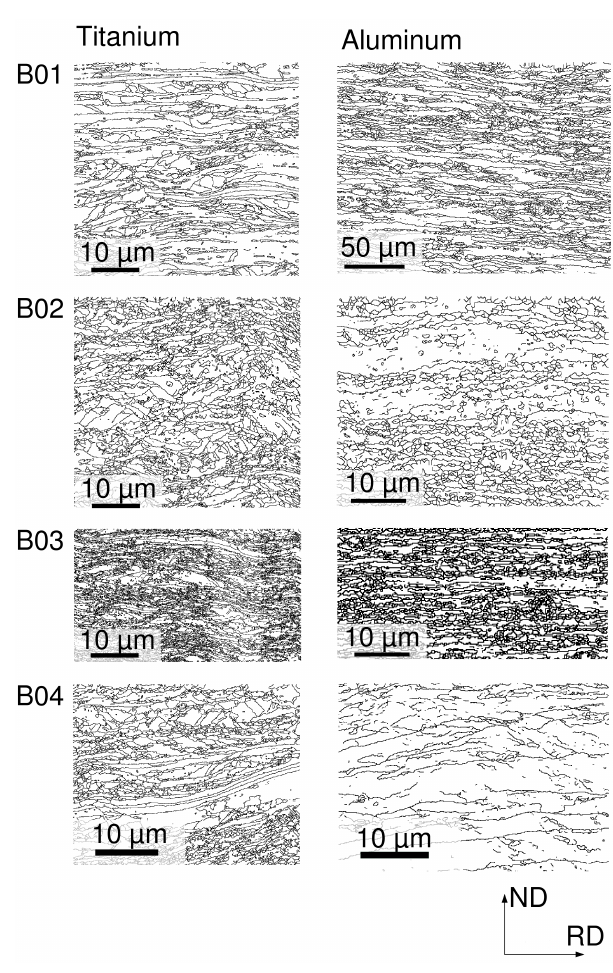
Figure 5. Grain boundary maps ( i.e. , boundaries with a misorientation angle of 15 degrees and above) for Al and Ti being co-deformed by ARB within a five-layer stack and subsequent DSR. B01: one rolling pass, speed ratio: 1:1; B02: one rolling pass, speed ratio: 1:5; B03: four rolling passes, speed ratio: 1:1; B04: conventional rolling with three rolling